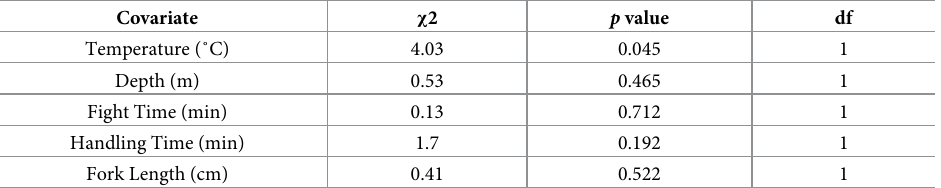
Table 5. Results of Kruskal-Wallis’ test for significant differences in environmental and capture covariates between blacktip sharks that survived capture and release and blacktip sharks that experienced post-release mor- tality. Capture covariates included fight time, handling time, and shark fork length. Environmental covariates of initial temperature and initial depth were taken from an individual’s tag data as an average of the first 10 minutes immediately following